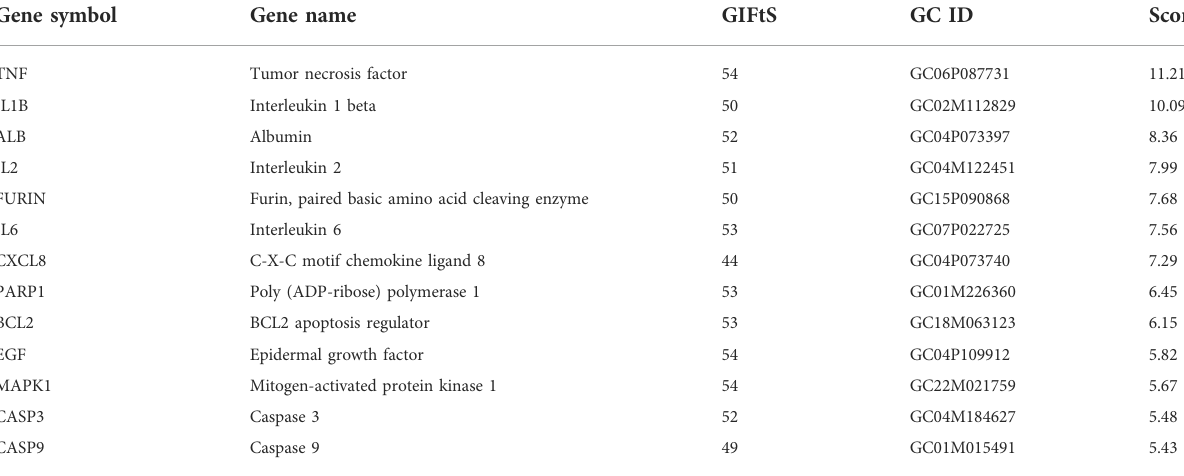
TABLE 2 T-2 toxin-related genes from GeneCards based on the score more than